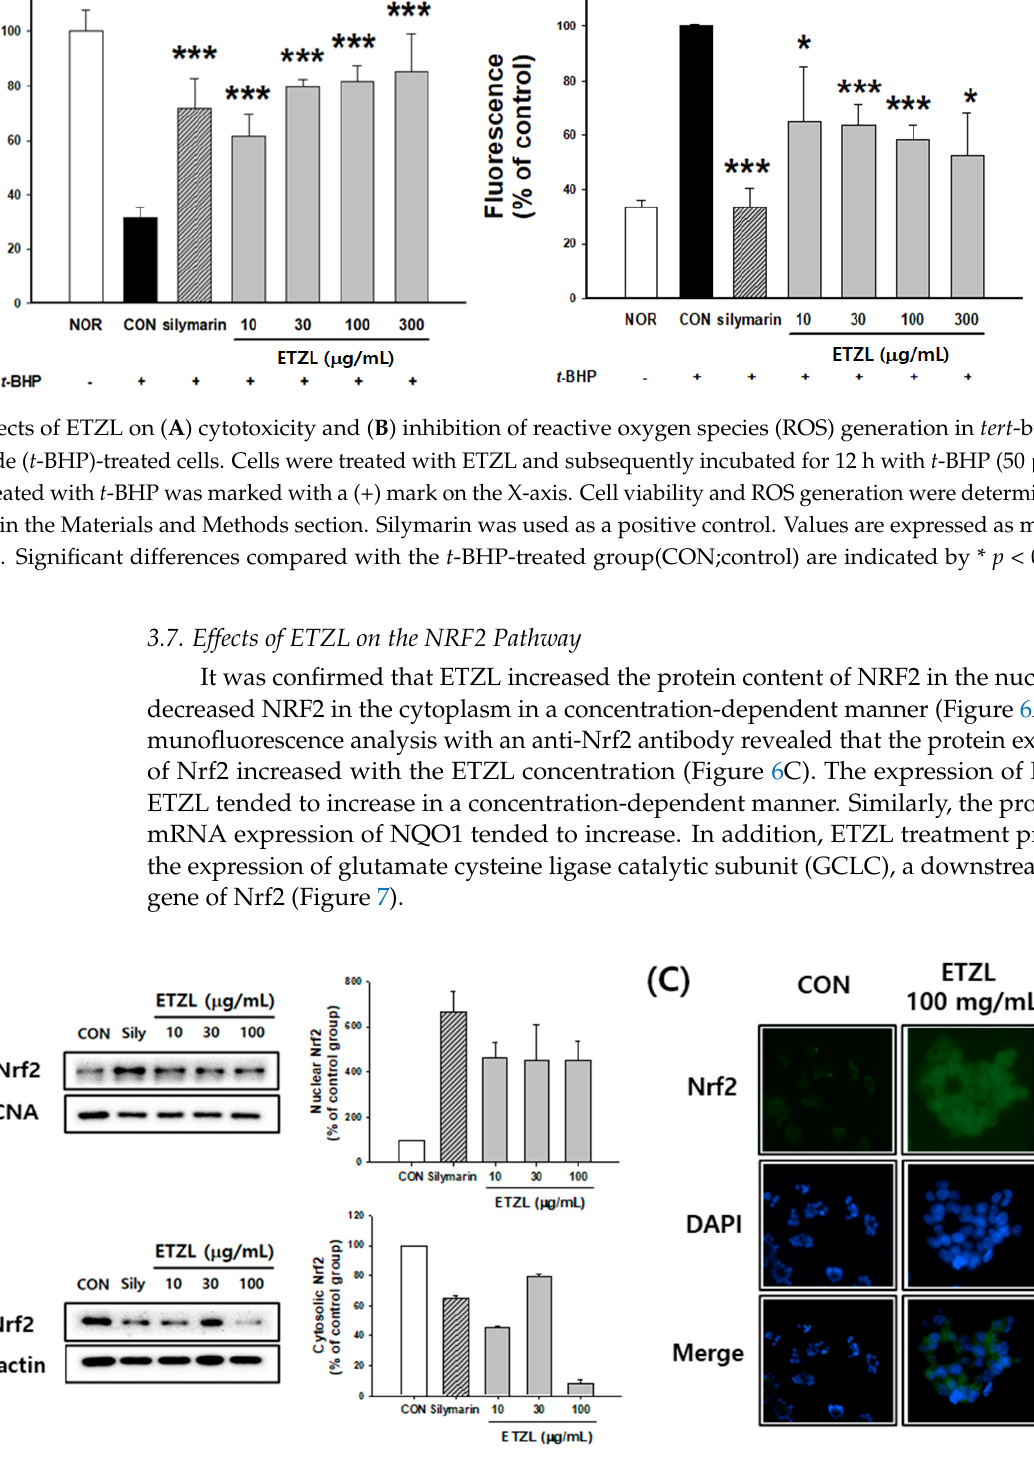
Figure 6. Effect of ETZL on nuclear factor erythroid-derived 2-related factor 2 (Nrf2) activation in HepG2 cells. Cells were treated with indicated concentrations of ETZL for 12 h and Nrf2 translocation was determined. ( A ) ETZL treatment induced Nrf2 protein expression in nucleus. ( B ) ETZL treatment induced Nrf2 protein expression in cytosol. ( C ) ETZL treatment promoted Nrf2 protein nucleus accumulation in HepG2 cells (400 × ). Values are expressed as mean ± SD ( n =